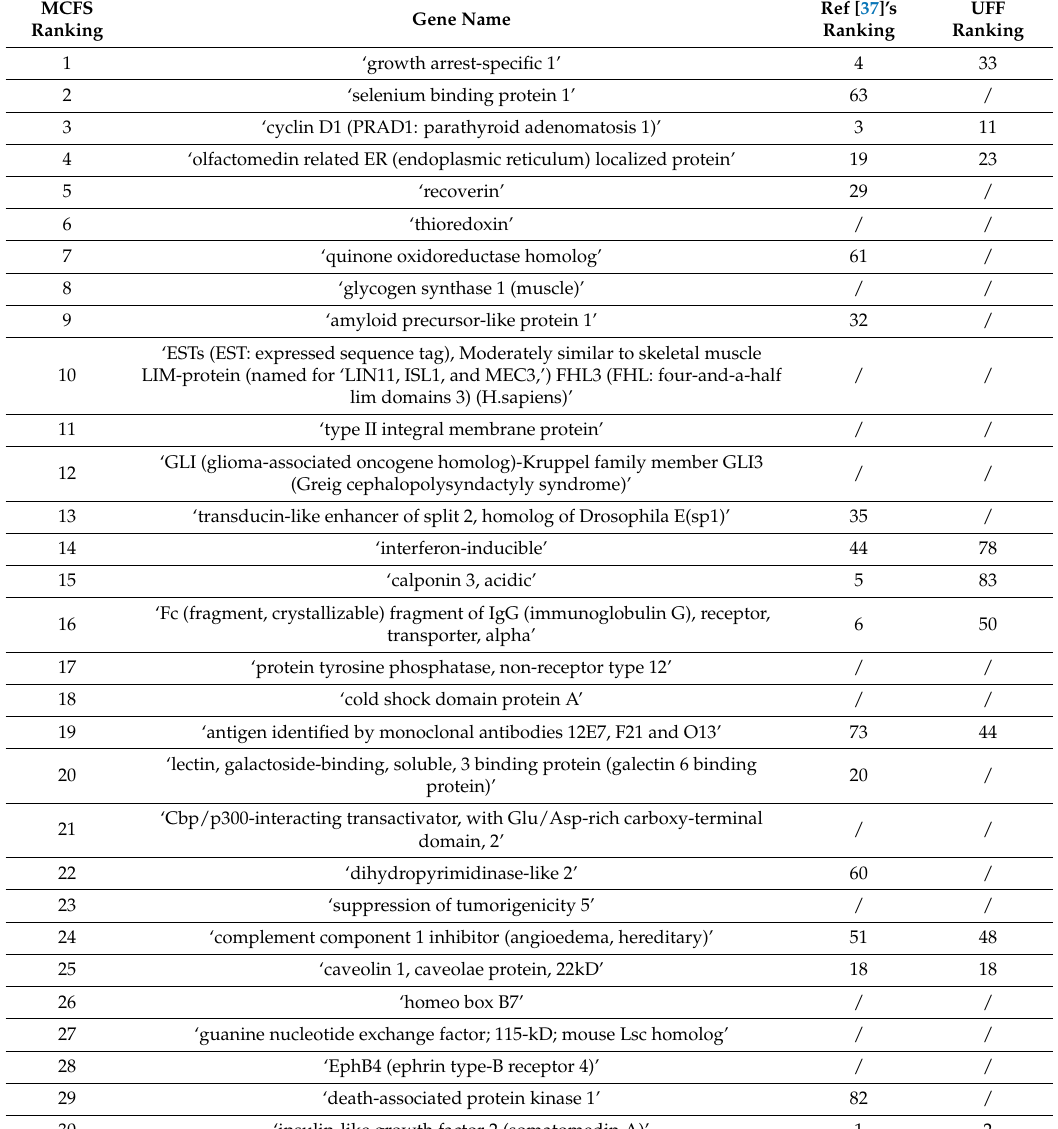
Table 6. Top 30 genes selected by